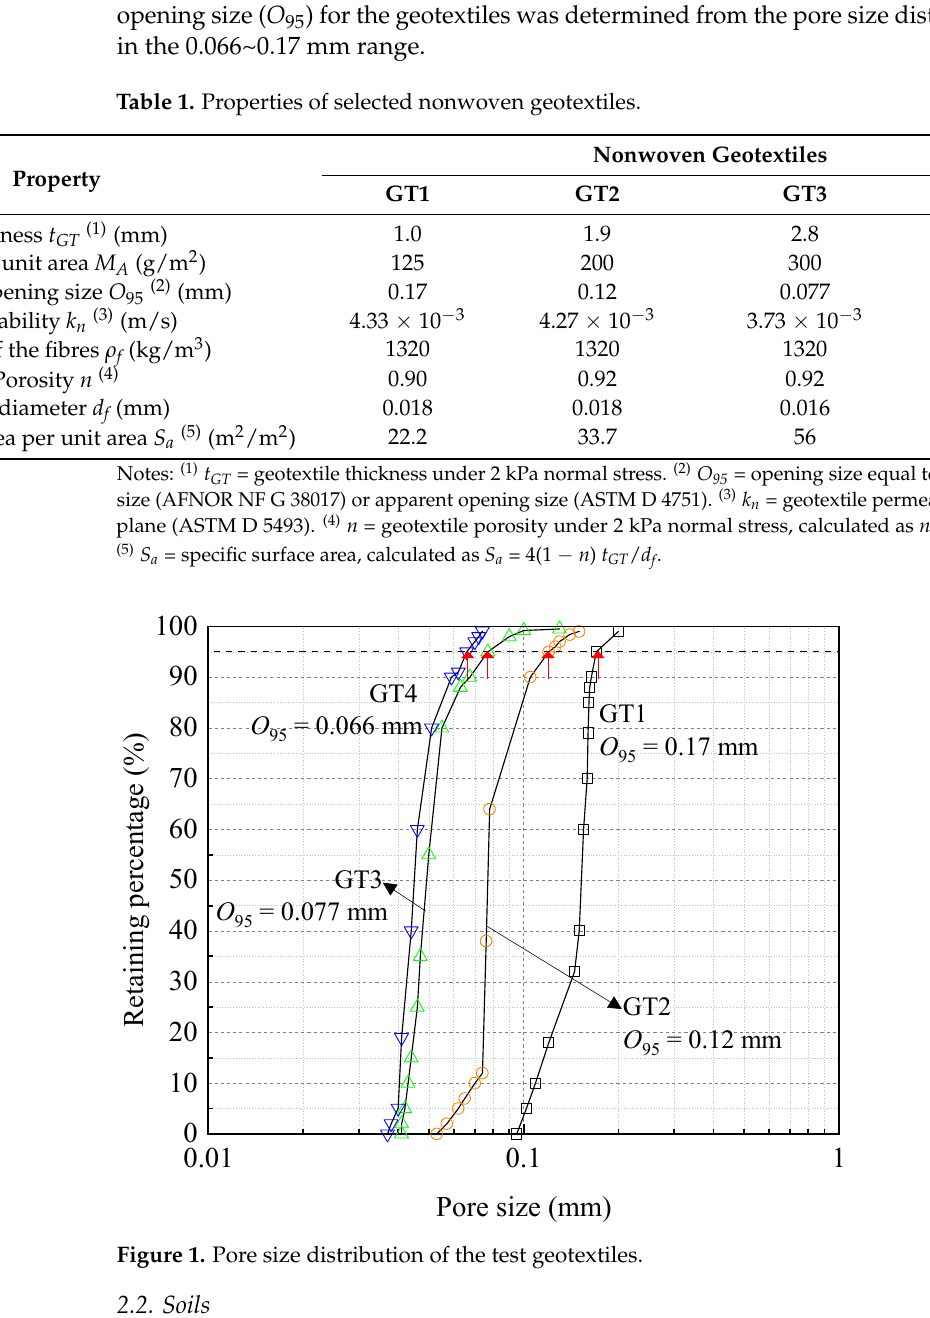
Table 1. Properties of selected nonwoven geotextiles.